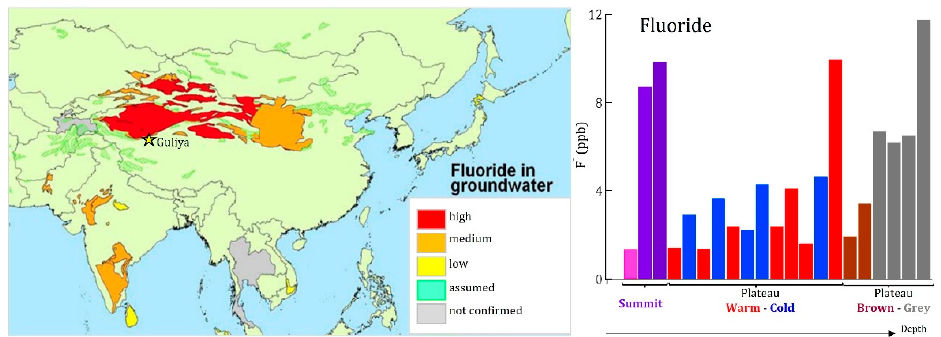
Figure A3. Spectral plot and Backscattered Electron (BSE) image of a HREE-bearing xenotime iden- tified on dust filter T309 by EDXS trace mineralogy analysis.